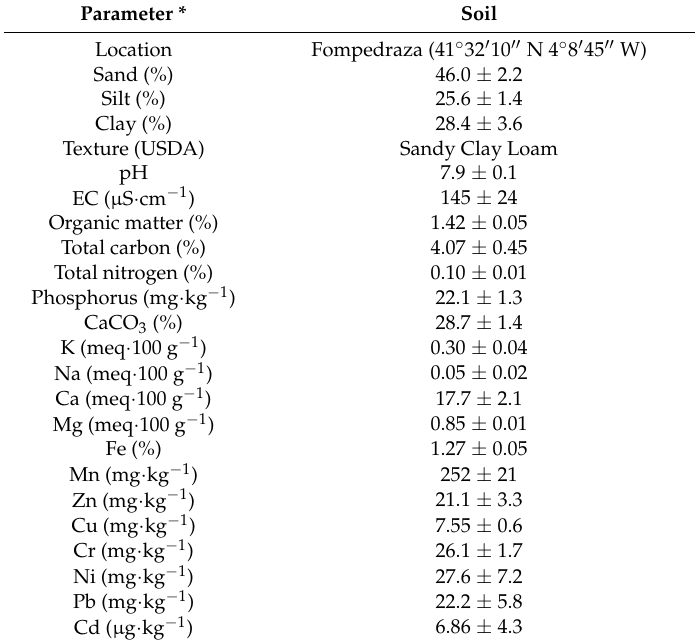
Table A1. Physicochemical soil properties before the application of